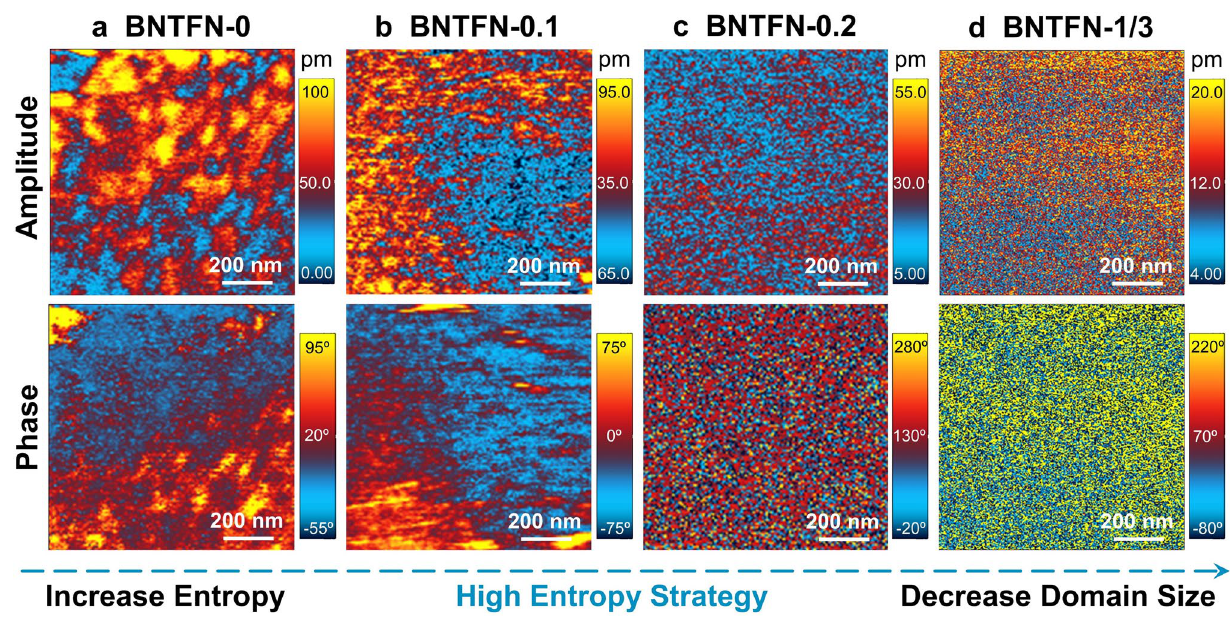
Fig. 3 Transformation of domain morphology by increasing configuration entropy. Out-of-plane PFM amplitude and phase images of ( a ) BNTFN-0, ( b ) BNTFN-0.1, ( c ) BNTFN-0.2, and ( d ) BNTFN-1/3